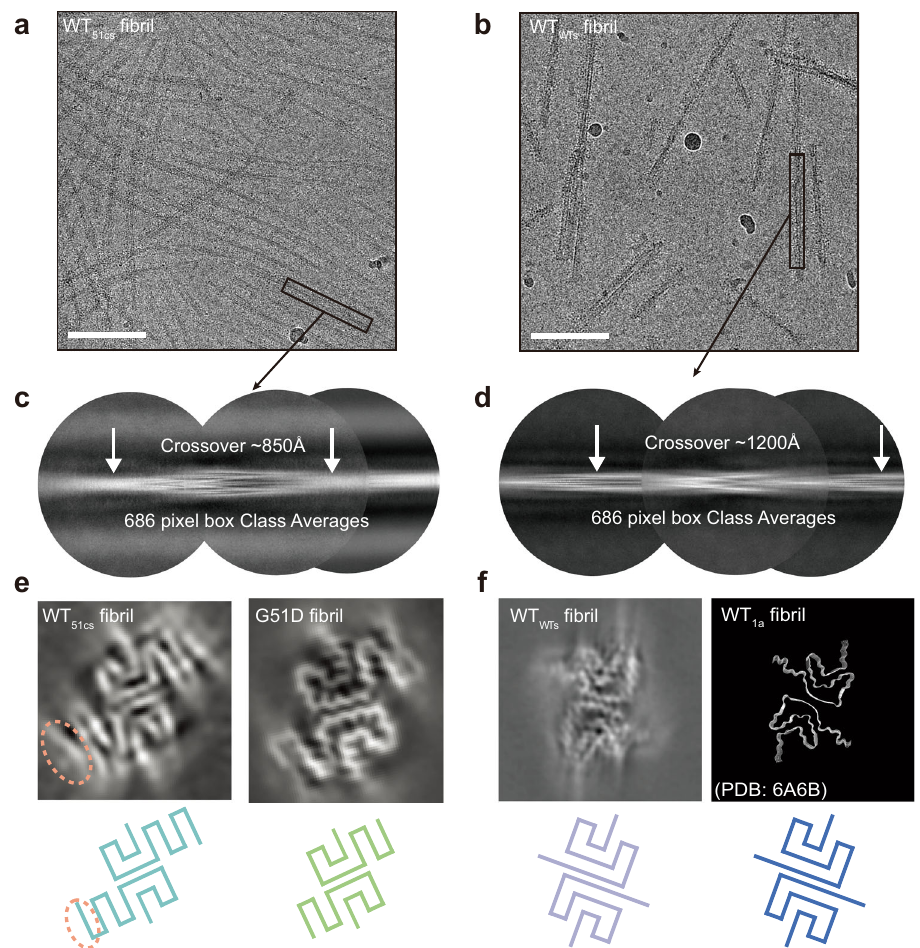
Fig. 5 Cryo-EM study of WT 51cs and WT wts strains. Cryo-EM micrographs of WT 51cs strain ( a ) and WT wts strain ( b ) are shown. The images